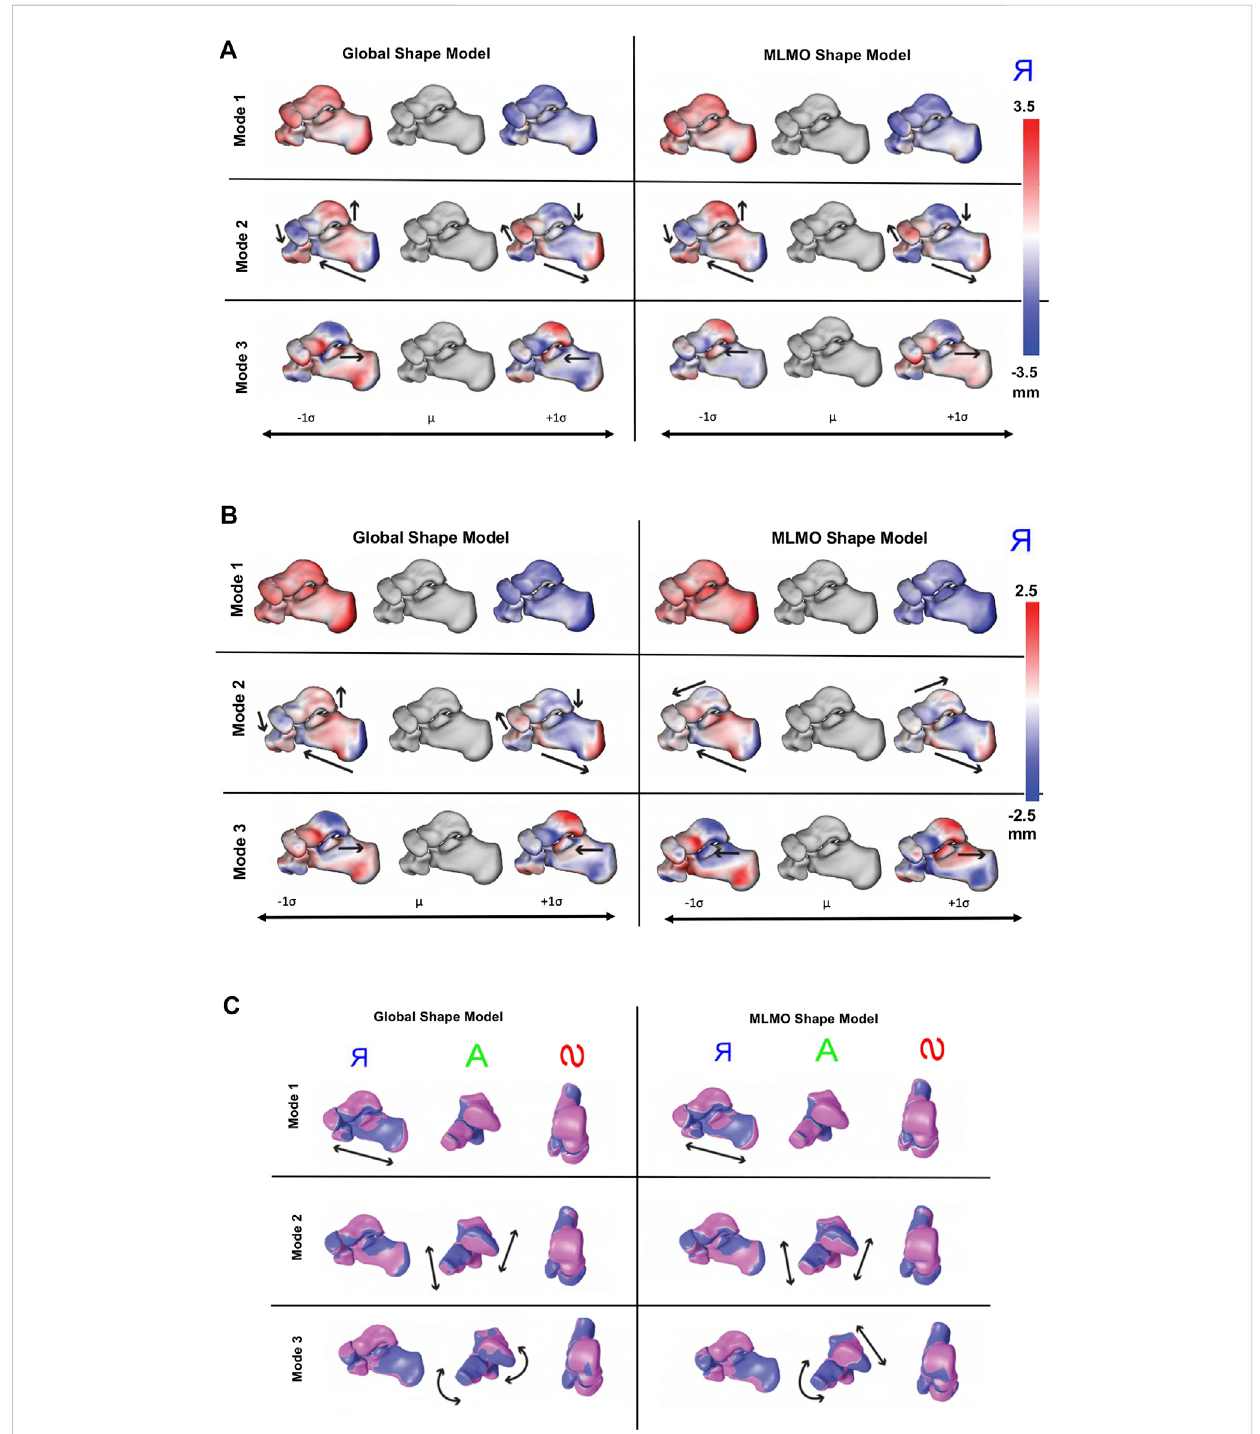
FIGURE 8 Qualitative results for foot andankle data. (A) PCAmodes ofvariation.The colormapshows thedistanceof eachmodefromthemean shape. mean shape. Thearrowsdenotethedirection along which signi fi cant shapechanges takeplace. (B) Within-organmodesofvariation.The colormapshowsthe distance of each mode from the mean shape. The arrows denote the direction along which signi fi cant shape changes take place. (C) Between-organs modes of variation — Medial, Anterior and Superior View. The mean shape is grey in color with +1 σ modes shown in blue and − 1 σ modes shown in pink